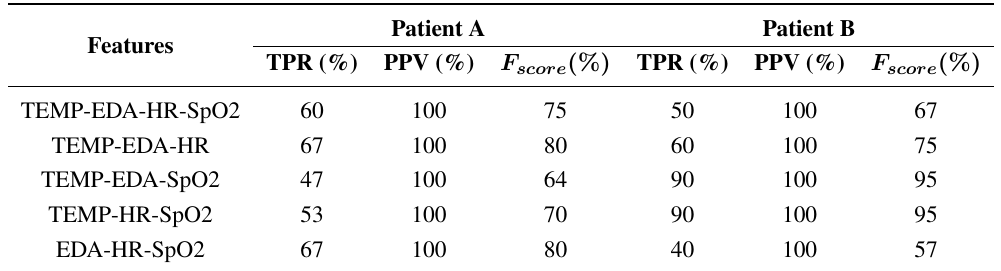
Table 5. Trust levels on models selected for a fit reference of 70%. TPR, true positive rate; PPV, positive predictive